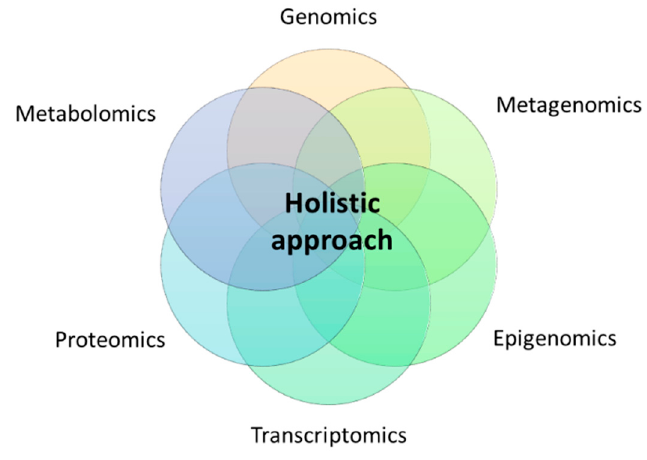
Figure 1. Holistic approach for precision nutrition using multi-omics technologies.